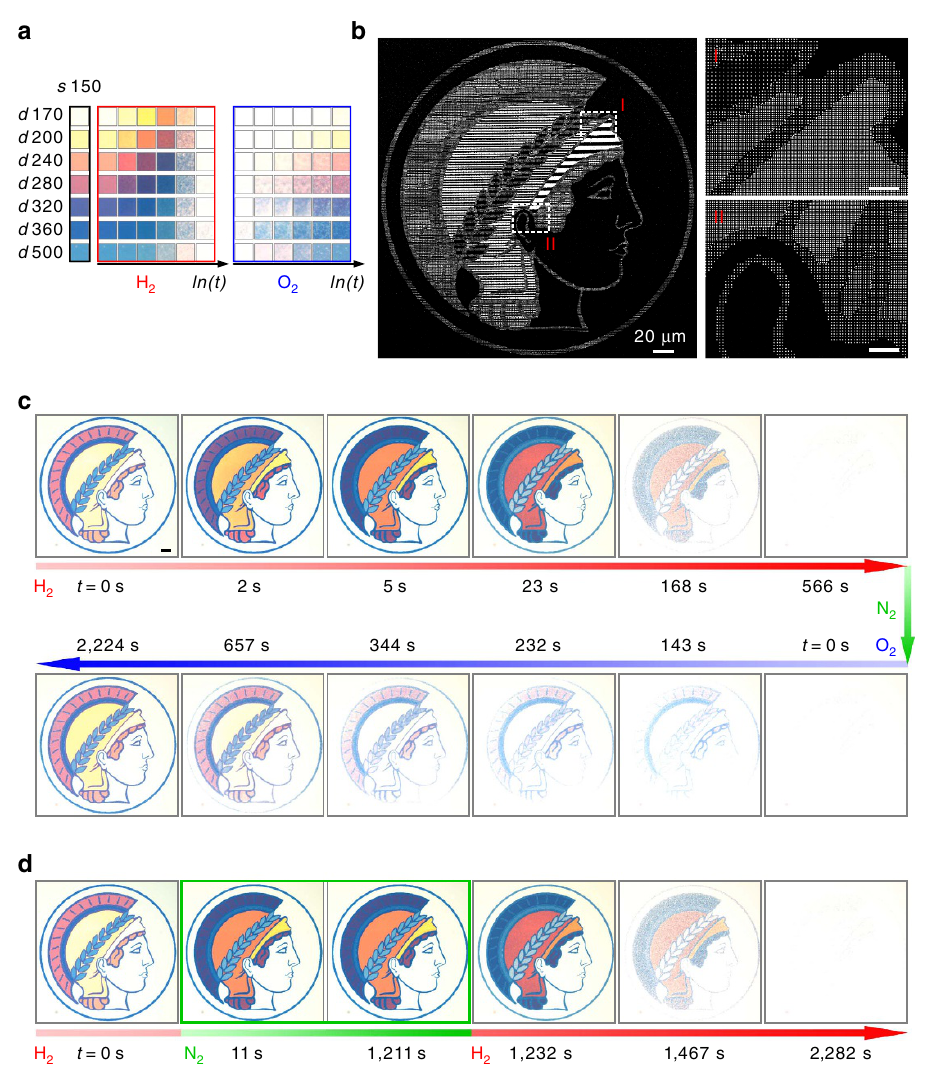
Figure 2 | Dynamic colour erasing and restoring of the Max-Planck-Society’s Minerva logo microprint. ( a ) Colour evolutions of the selected colours used to construct the Minerva logo during hydrogenation and dehydrogenation, respectively. ( b ) Overview and enlarged SEM images of the Minerva logo. The scale bars in I and II are 5 m m. ( c ) Optical micrographs of the Minerva logo during hydrogenation and dehydrogenation for colour erasing and restoring, respectively. Scale bar: 20 m m. ( d ) Colour state ‘freezing’ by switching off